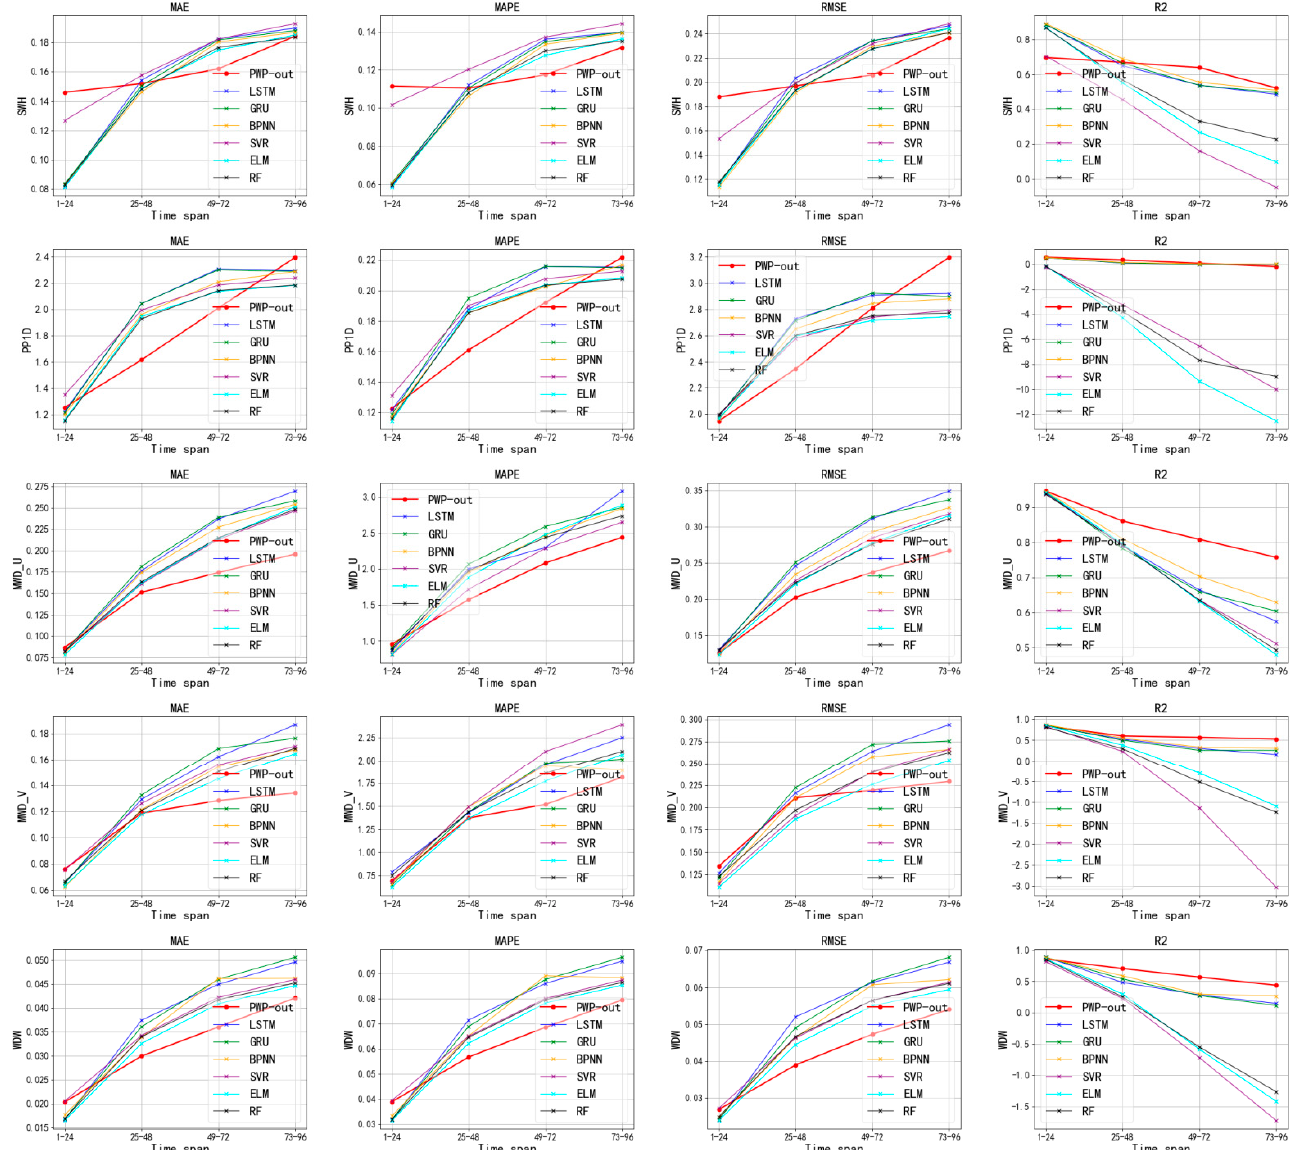
Figure 8. Performance comparison between PWP-out and other